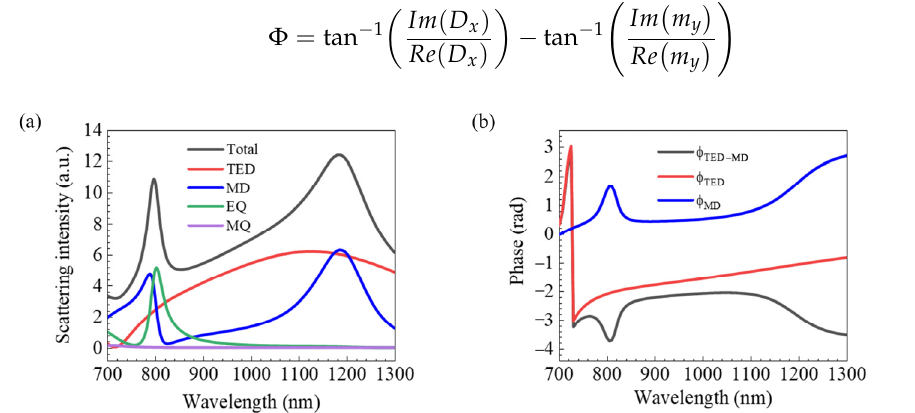
Figure 3. ( a ) Multipole decomposition scattering intensity, and ( b ) electric dipole and magnetic dipole phase and phase difference.